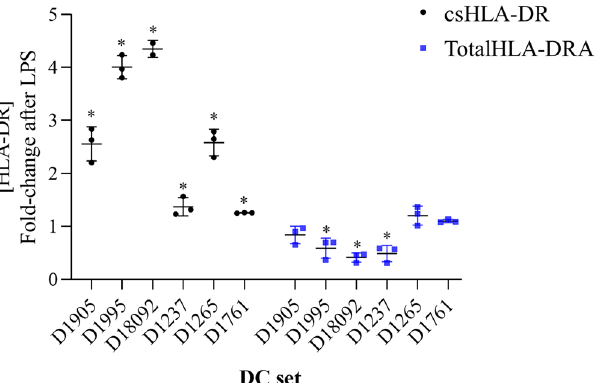
Figure 6. DCs display increased levels of csHLA-DR upon LPS-activation in contrast with total levels HLA- DRA1 α-chain. csHLA-DR and totalHLA-DRA1 fold induction between unstimulated and LPS-treated DCs, statistical significance was analyzed with a two-tailed Student’s t Test (* p < 0.05). Each point for csHLA-DR represents a replicate (n = 3). For totalHLA-DRA1 each point represents the mean for two injections corresponding to 25,000, 50,000 and 100,000 cells per donor (n = 3) and the SD (error